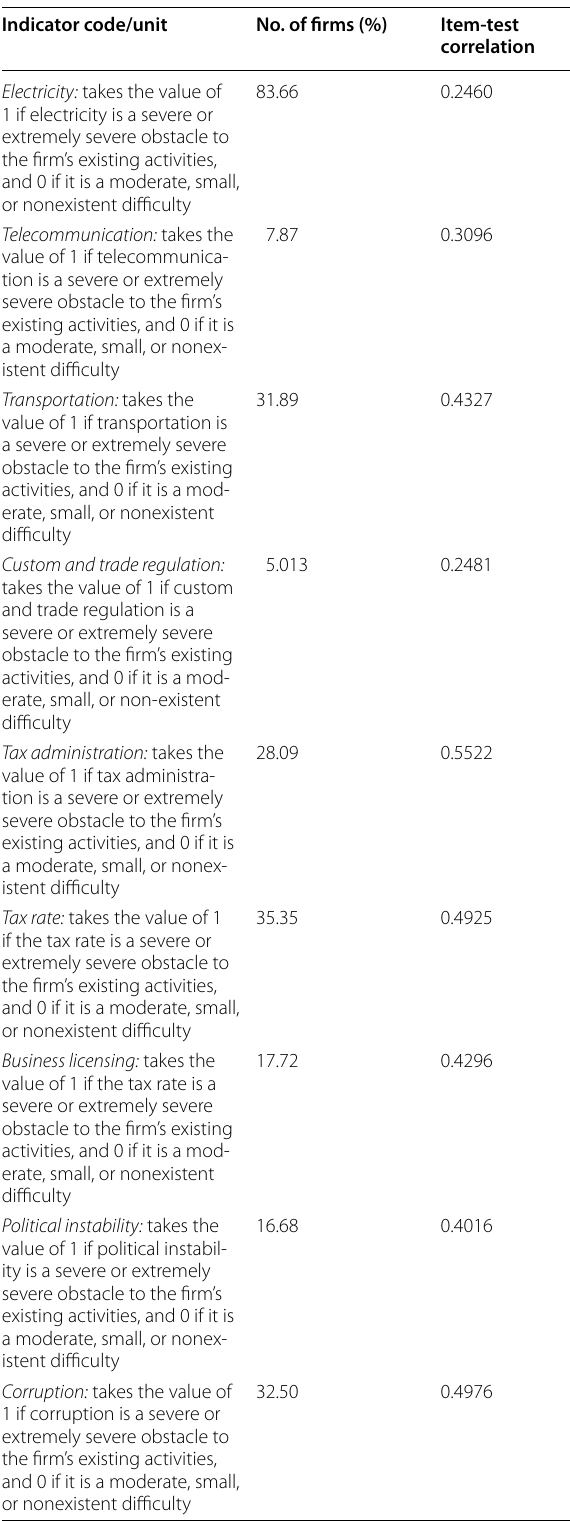
Table 1 Indicators used in generating the business